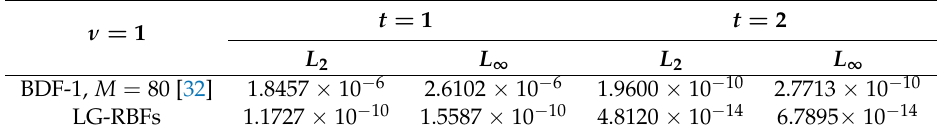
Table 4. Comparison of error norms for different values of final times with M = 10 and ∆ t = 0.001.